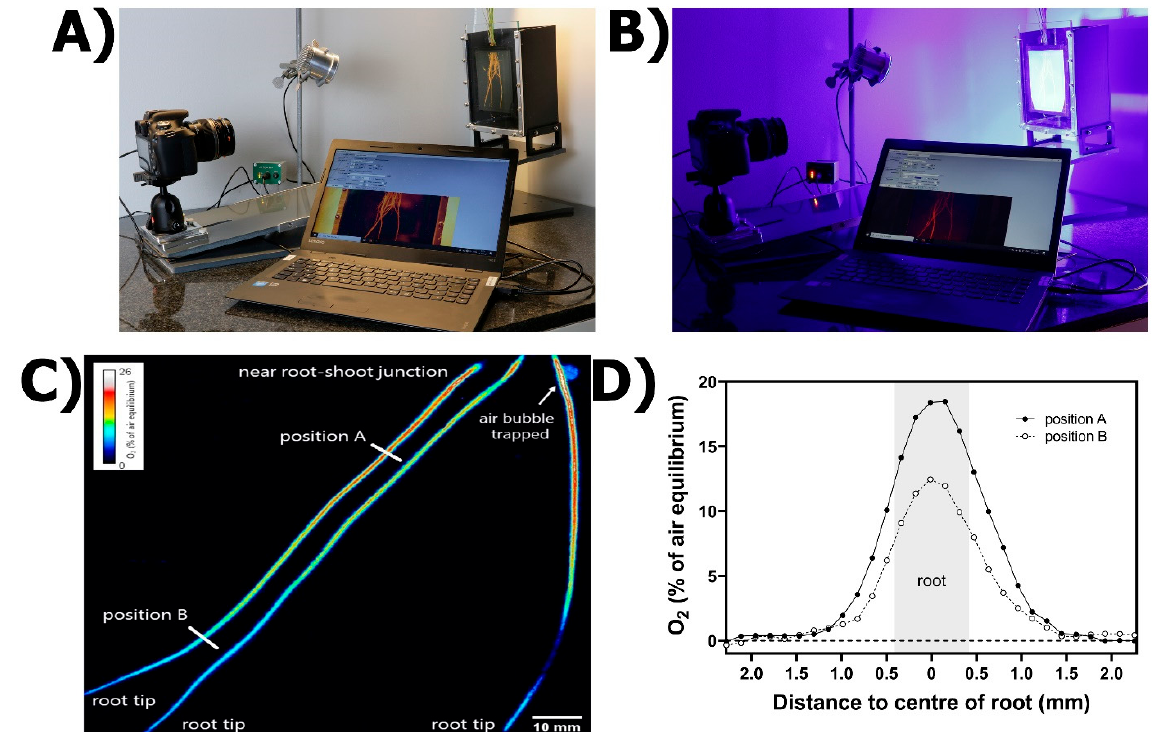
Figure 5. Planar optodes for ROL determination from roots. ( A ) General set-up, including a chamber filled with anoxic medium and the roots of an intact rice plant submerged, a digital camera, blue LED lights and software for image analysis (see text and Supplementary Information S4 for details). ( B ) Image collection process in darkness. ( C ) O 2 planar optode image indicating differences in ROL in roots of Puccinellia festuciformis grown in aerated conditions for 5 weeks. ( D ) ROL quantification in the regions of interest. Oxygen concentrations in D refer to specific positions of the root, as shown in C.